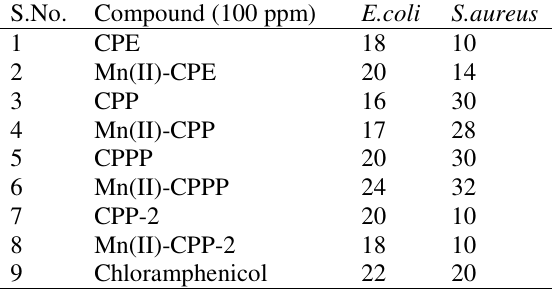
Table 4. Antibacterial activity of synthesized compounds